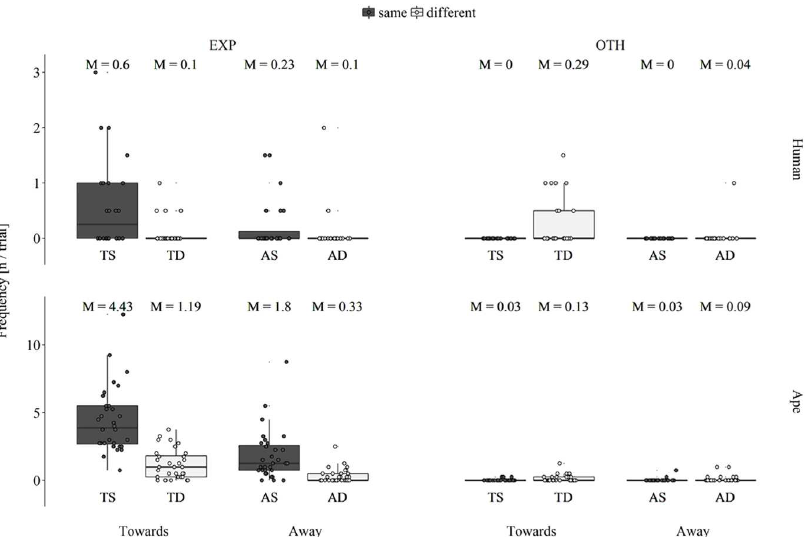
Fig 4. Box plot of the average number of pointing gestures per trial that human infants (upper row) and apes (lower row) directed towards the experimenter’s side (EXP: left column) and the other side (OTH: right column) across the factors orientation (Towards: two leftmost boxes in each plot, Away: two rightmost boxes in each plot) and location (red: experimenter and reward are on the same side, blue: experimenter and reward are on different sides) resulting in the four experimental conditions towards-same (TS), towards-different (TD), away-same (AS) and away-different (AD); M: condition mean value, the middle line of each box represent population median values (different from the M above each box); lower and upper hinges display first and third quartiles, respectively; whiskers extend up to 1.5 x interquartile range, small circles represent individual data